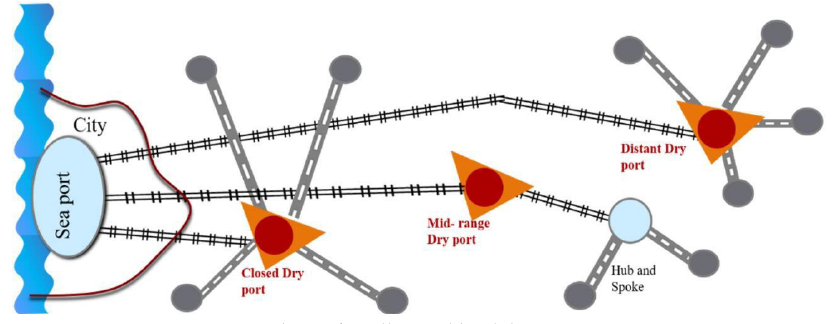
Figure 6. Fully combined dry